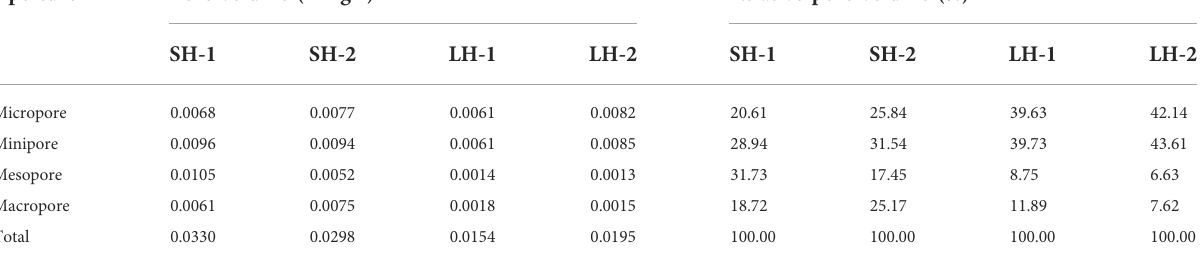
TABLE 2 Pore size distribution characteristics of coal samples.